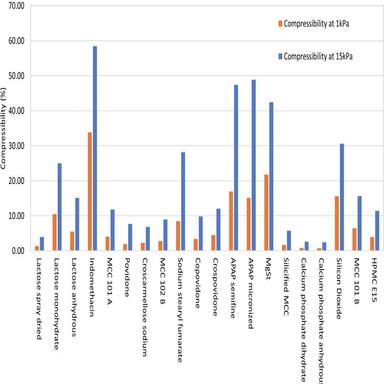
Material characterization results from permeability test at a consolidation stress of 1 kPa and 15 kPa.